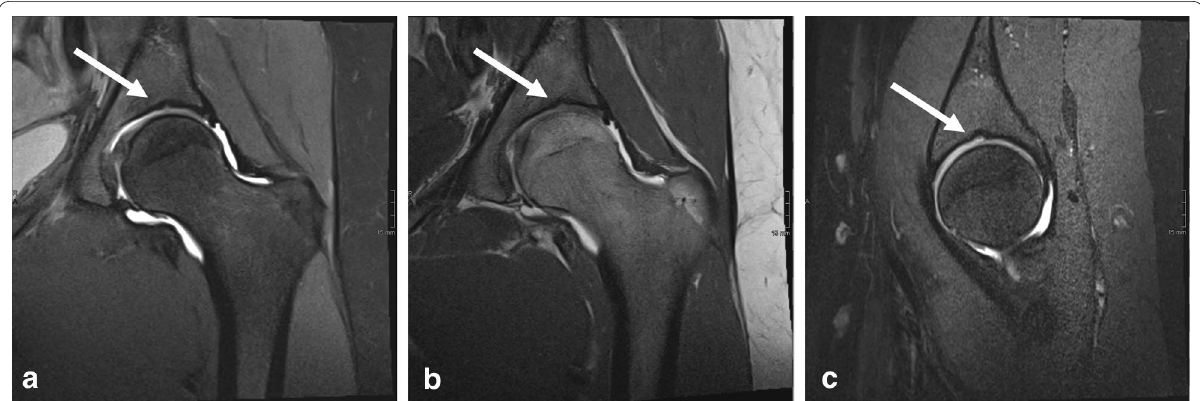
Fig. 4 MR-Arthrography of the hip of a 21-years-old, female participant with SAF type 2 on left side (white arrow): Proton density weighted (PD) coronal ( a ), T1 weighted sagittal ( b ) and PD weighted sagittal ( c )